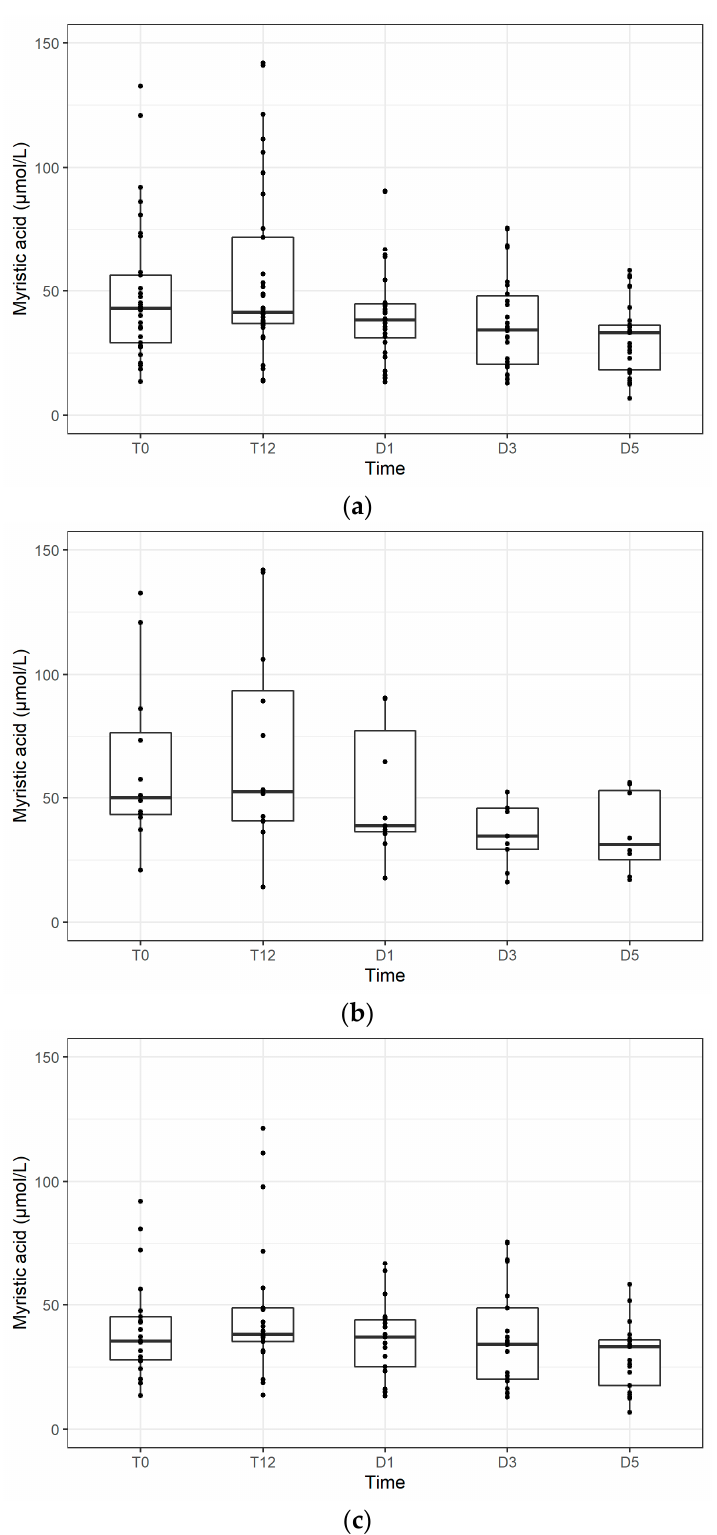
Figure 2. The progress of myristic acid levels at individual times ( a ) in the Sepsis Group as a whole, ( b ) in the subgroup of septic patients with bacteraemia, and ( c ) in the subgroup of septic patients without bacteraemia.